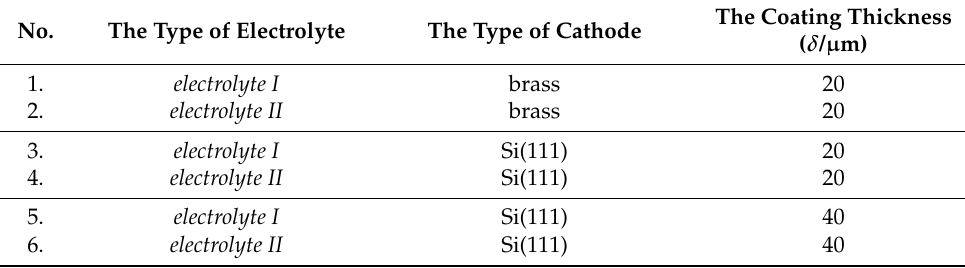
Table 1. The conditions of electrodeposition applied for a formation of uniform Cu coatings. In all experiments: j = 50 mA cm − 2